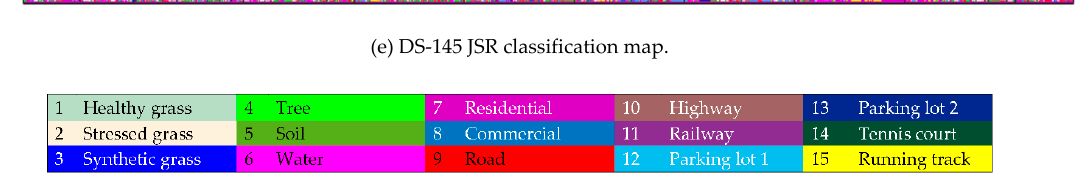
Figure A8. JSR classification maps.